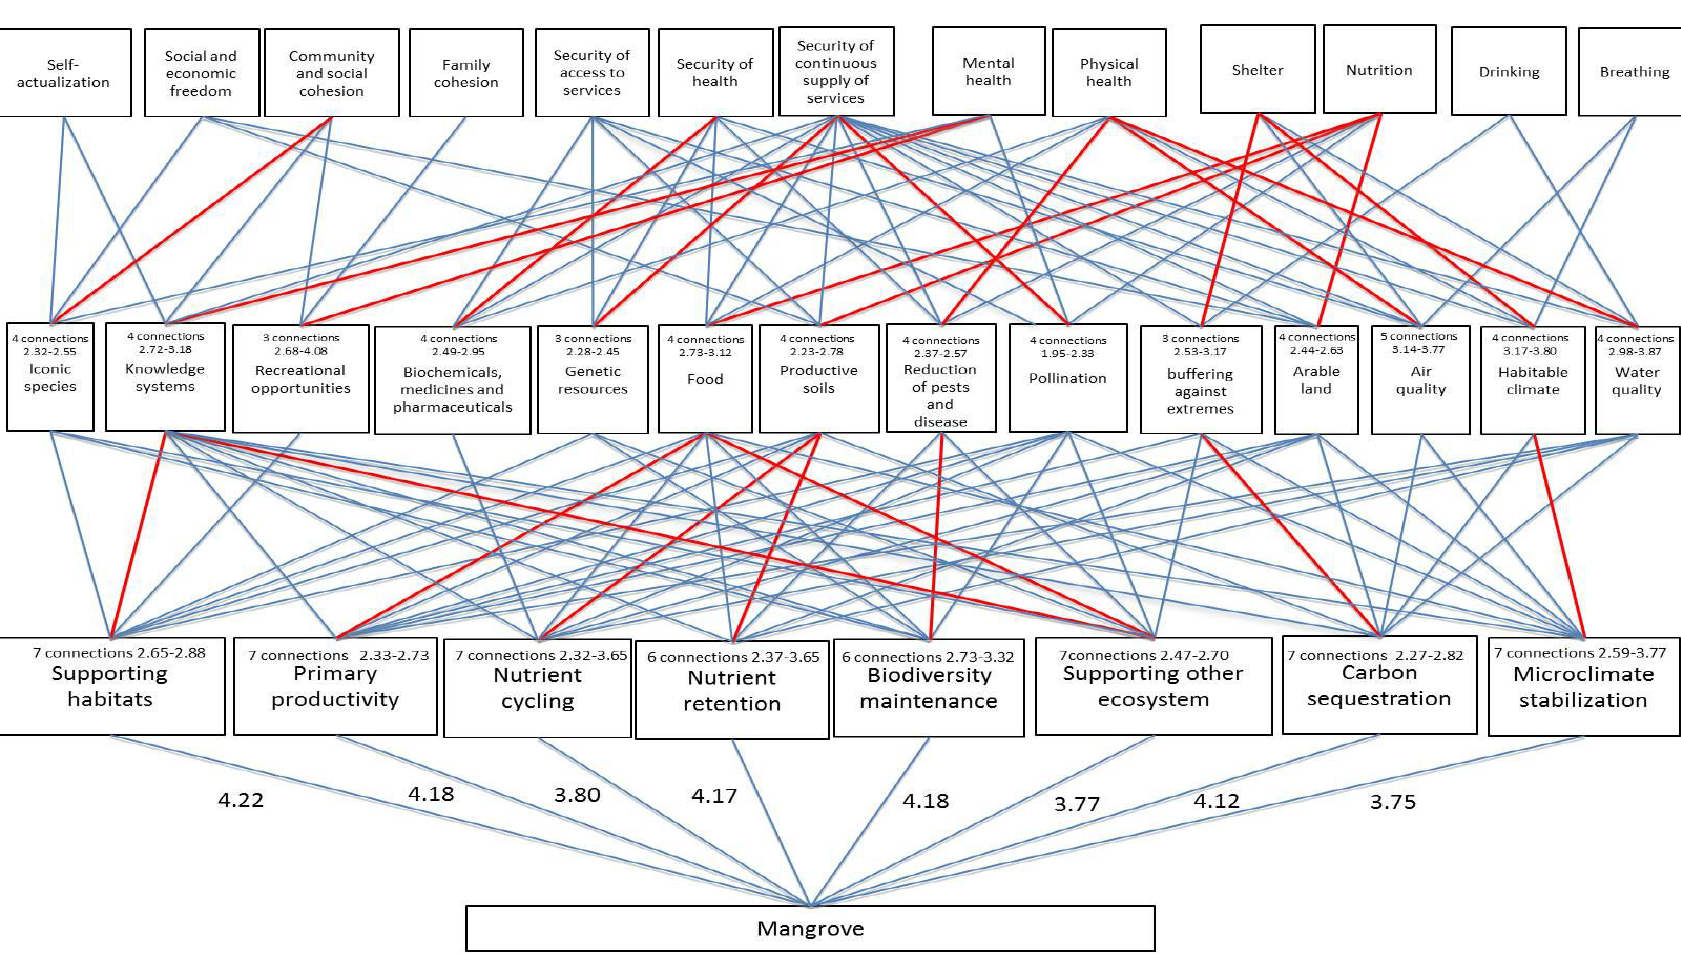
Figure 3. The connection network for the components of ecosystem functions, ecosystem services and human wellbeing provided by the Danshuei River mangrove system. Red lines depict paired connections with the highest scores, thus reflecting the most important relationships. Blue lines show the connections with Fuzzy values in the top 25%. Numerical numbers inserted in the top lines within boxes indicate the numbers of connections provided by ecosystem functions to ecosystem services and those by services to wellbeing. Numerical numbers following the word ―connection‖ in the top line are Fuzzy values with ranges from the top 25% to maximum